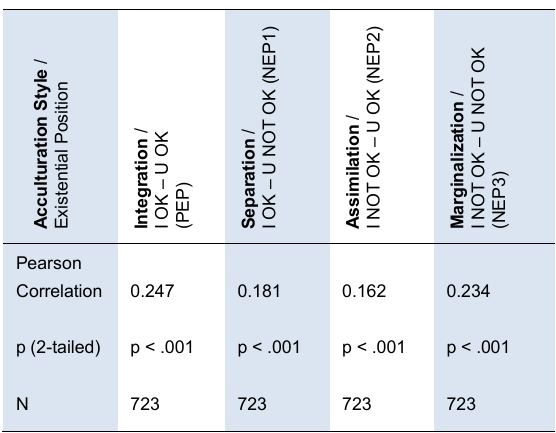
Table 4: Correlations between Existential Position